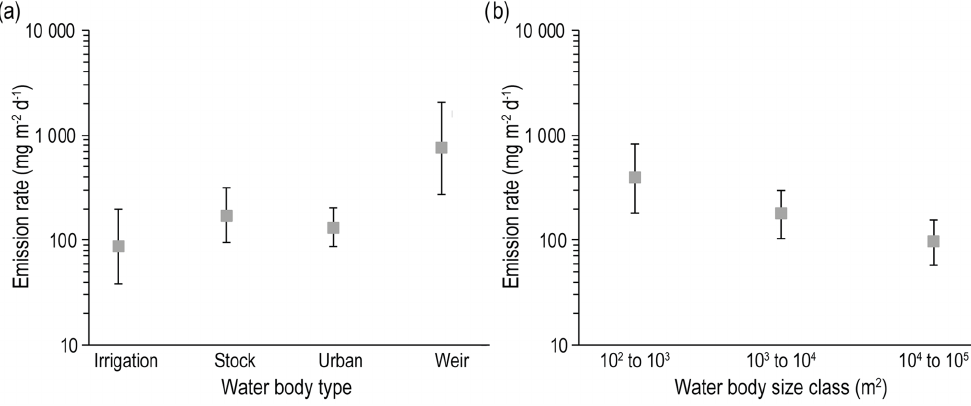
Figure 3. Mean CH 4 emissions across (a) four categories of small water bodies (irrigation dams, stock dams, urban lakes and weirs) and (b) three GRanD water body size classes. Values indicate geometric mean emission rates and 95% confidence intervals ( ± 95% CI).